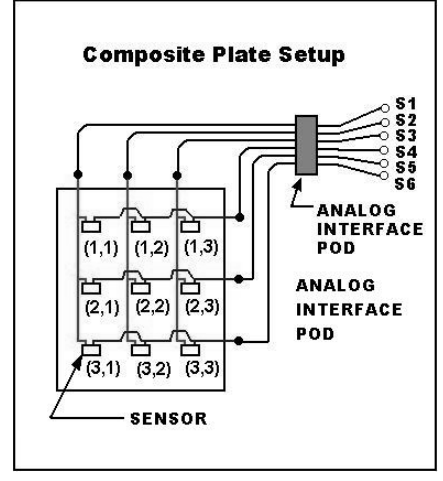
Fig. 3. Schematic view of the sensor placement on the composite